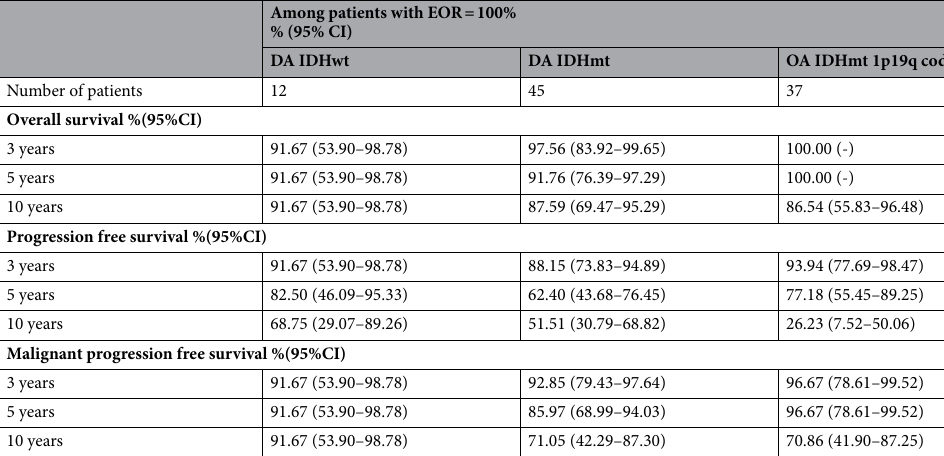
Table 6. Overall survival, progression free survival and malignant progression free survival at 3, 5 and 10 years after surgery in patients with total resection, stratified according to molecular diagnosis (WHO 2016). Table showing overall survival, progression free survival and malignant progression free survival at 3, 5 and 10 years after surgery according to molecular diagnosis (WHO 2016), in patients with Extent of Resection = 100%. EOR extent of resection, DA IDHwt Diffuse Astrocytoma Isocitrate Dehydrogenase wild type, DA IDHmt Diffuse Astrocytoma Isocitrate Dehydrogenase mutated, OD IDHmt 1p19q cod Oligodendroglioma Isocitrate Dehydrogenase mutated, 1p 19q